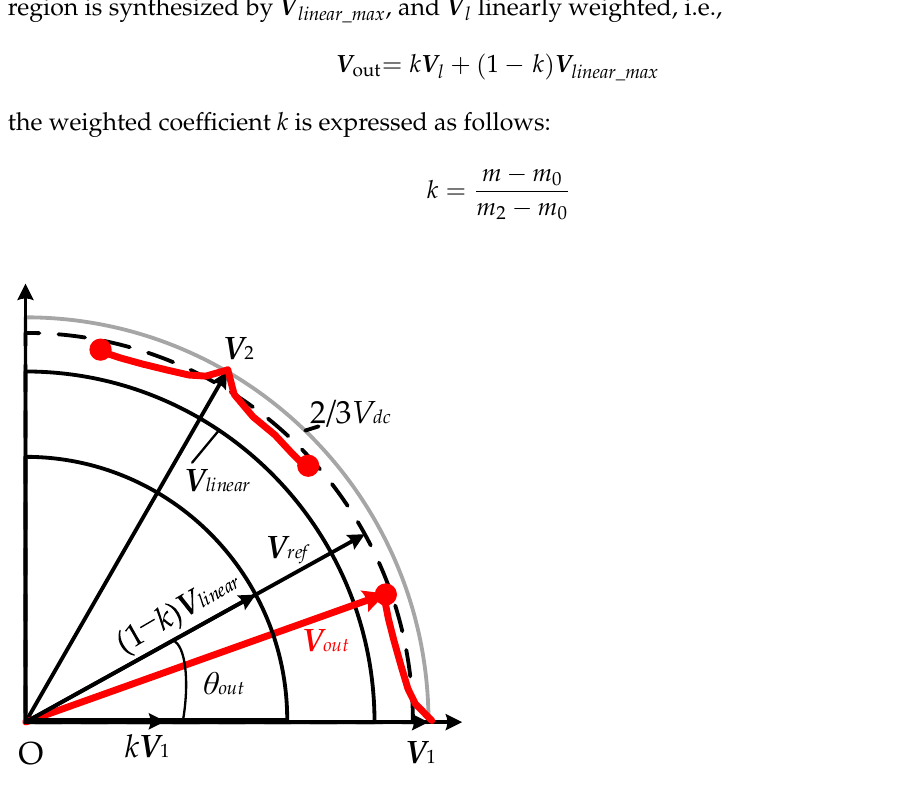
Figure 5. Single-mode space vector overmodulation based on limit trajectory Figure 5. Single ‐ mode space vector overmodulation based on limit trajectory superposition.